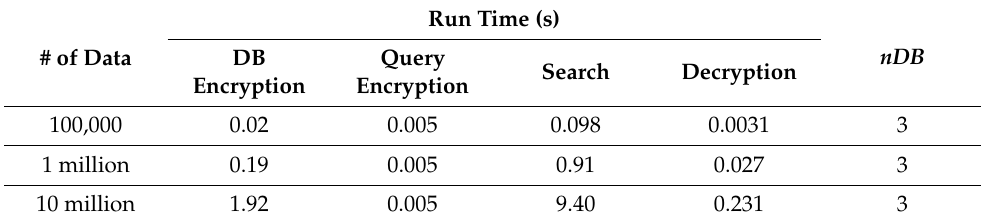
Table 4. Performance of the proposed scheme on the best